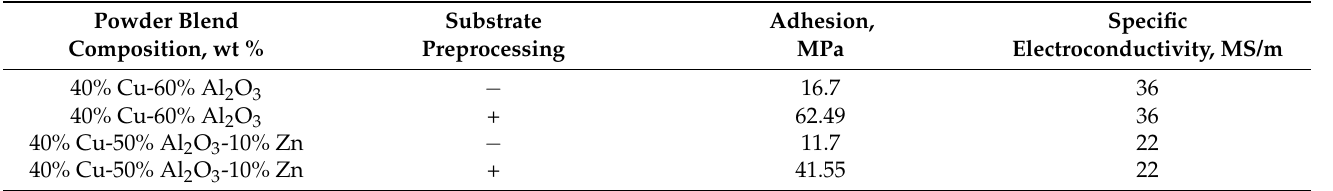
Table 1. Properties of the sprayed layer [23].